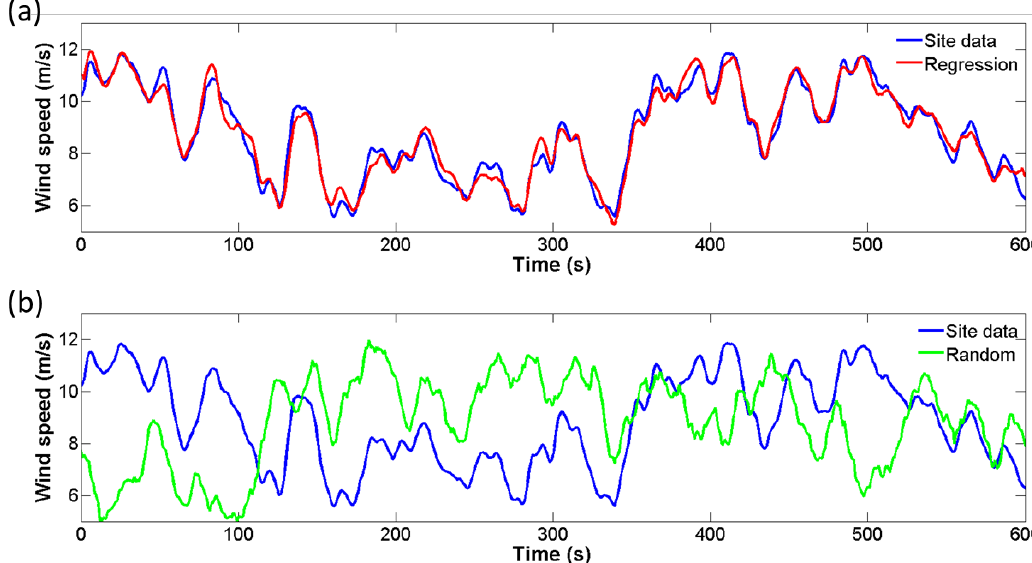
Figure 5. ( a ) Time-domain wind data reconstructed from power spectral densities (PSDs) based on site data; ( b ) Time-domain wind data with wind fluctuations added by randomizing the phase shifts.